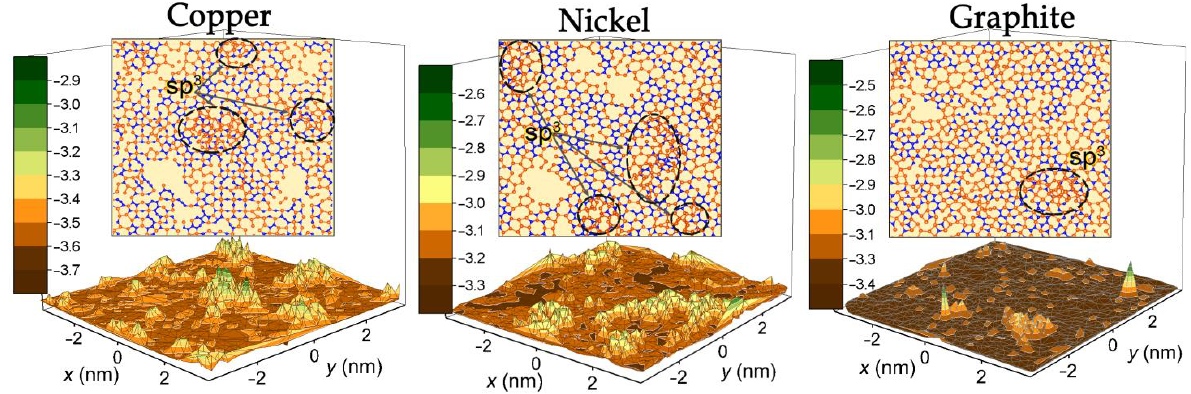
Figure 8. Main view of SiC films obtained on the various substrates, the simulation time for all types of systems is ≈ 40 ns. The color scale on the left represents the relief height of the obtained films. The insets show the xy -projections of the corresponding SiC films. Si atoms are marked in orange, and C atoms are marked in blue. Ovals indicate the centers of three-dimensional growth on the SiC film surfaces; the interaction between the deposited atoms (Si, C) and the graphite substrate is described by the Morse potential.